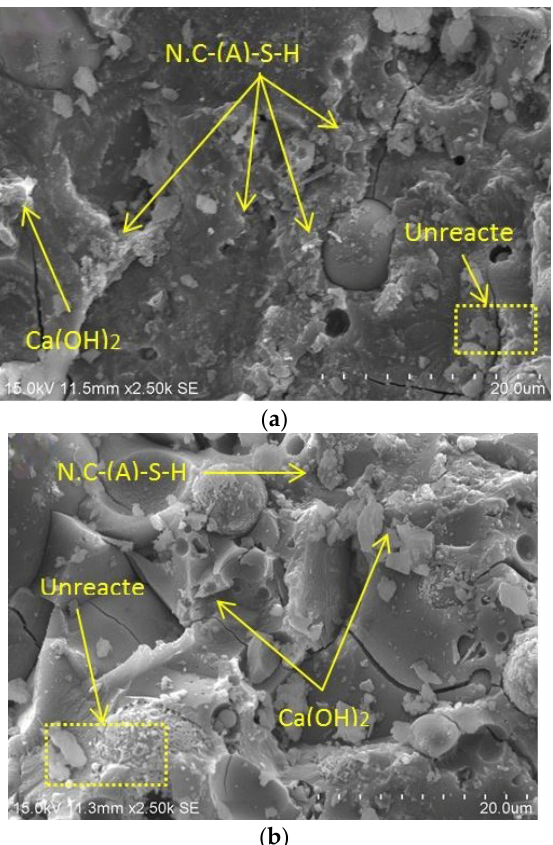
Figure 11. FESEM images of AAM containing various ratios of BGWNP ( a ) 5% and ( b ) 15% BGWNP.